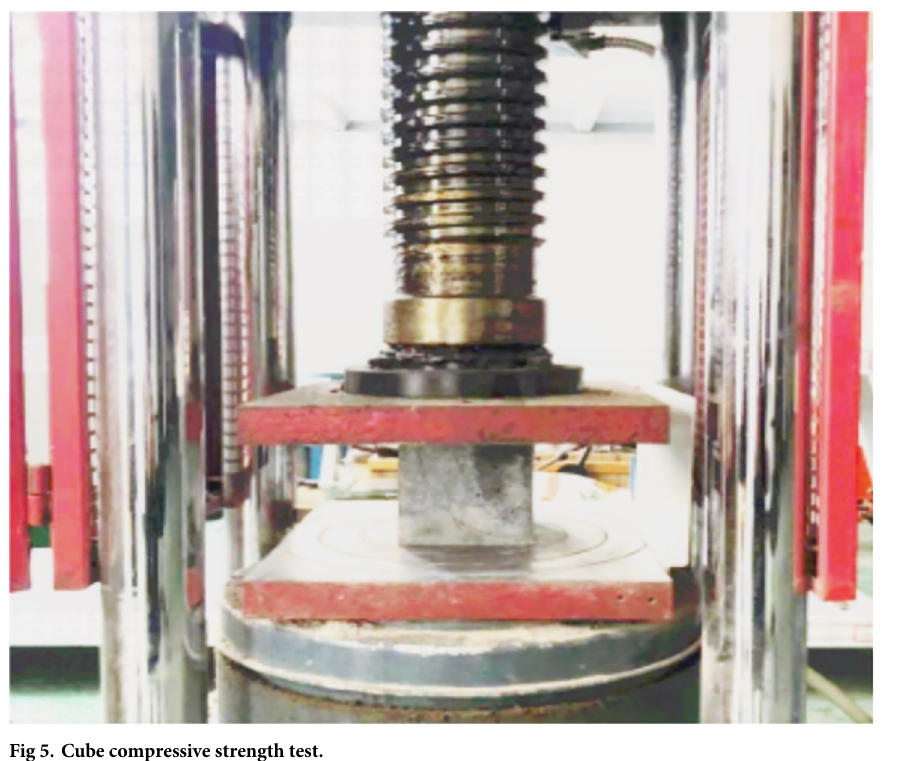
Fig 5. Cube compressive strength test.